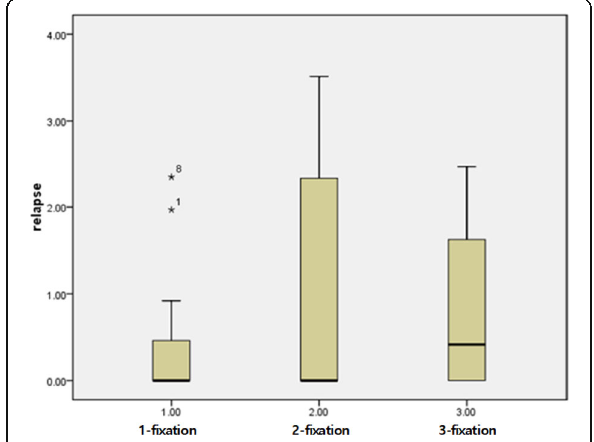
Fig. 2 The amount of displacement according to the number of fixations. The asterisk and numbers 1 and 8 mean the patient number who are in the 1-fixation